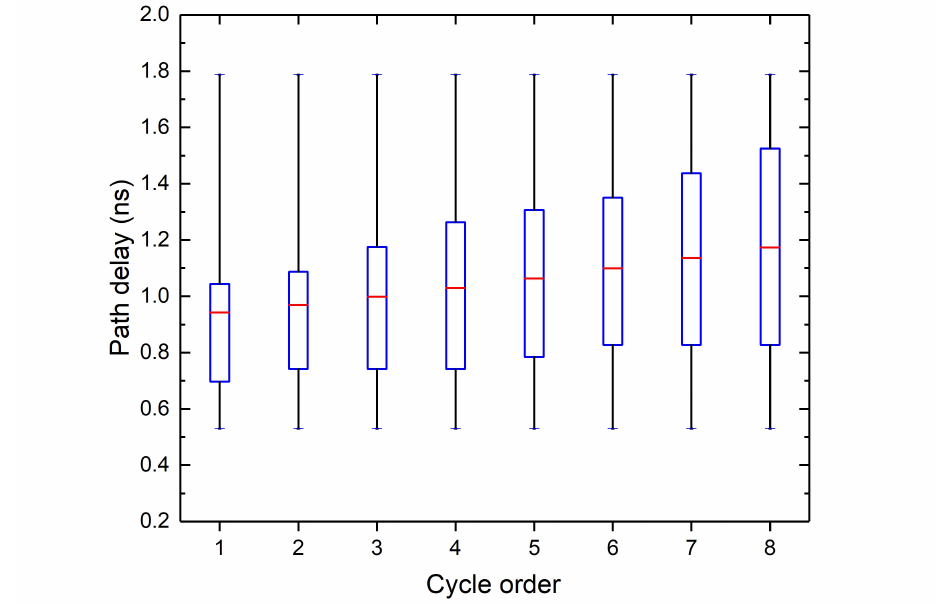
Figure 2. Distribution of path delay in each clock